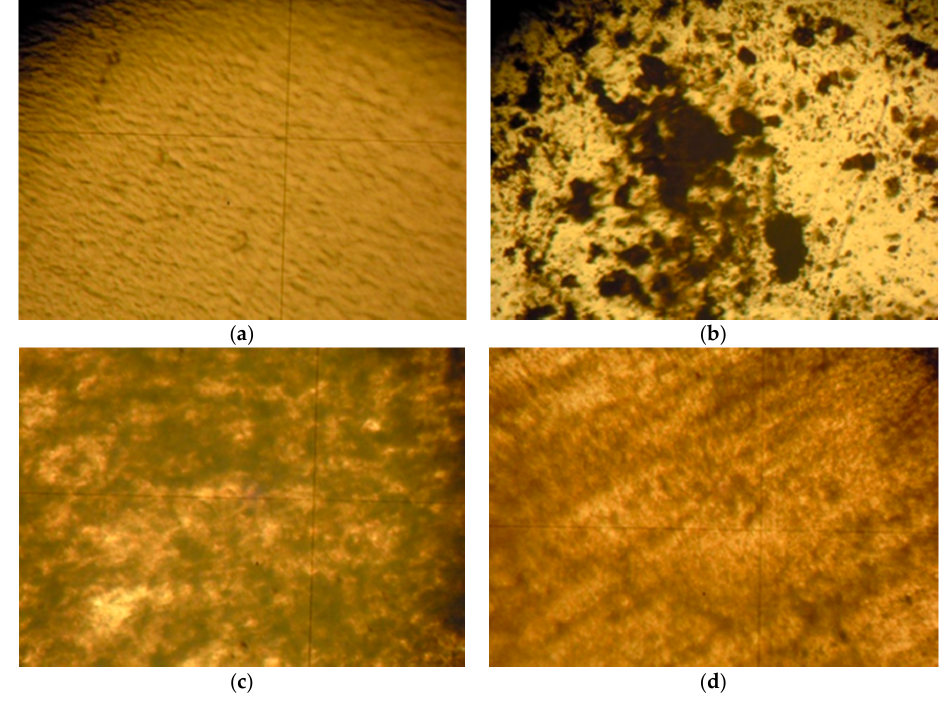
Figure 7. Optical micrographs (100×) of polyethylene films: ( a ) LDPE; ( b ) LDPE + 5% β CDTiO 2 NPs (mortar grinding); ( c ) LDPE + 5% TiO 2 NPs (cryo-milled mixture); ( d ) LDPE + 5% β CDTiO 2 NPs (cryo-milled mixture).